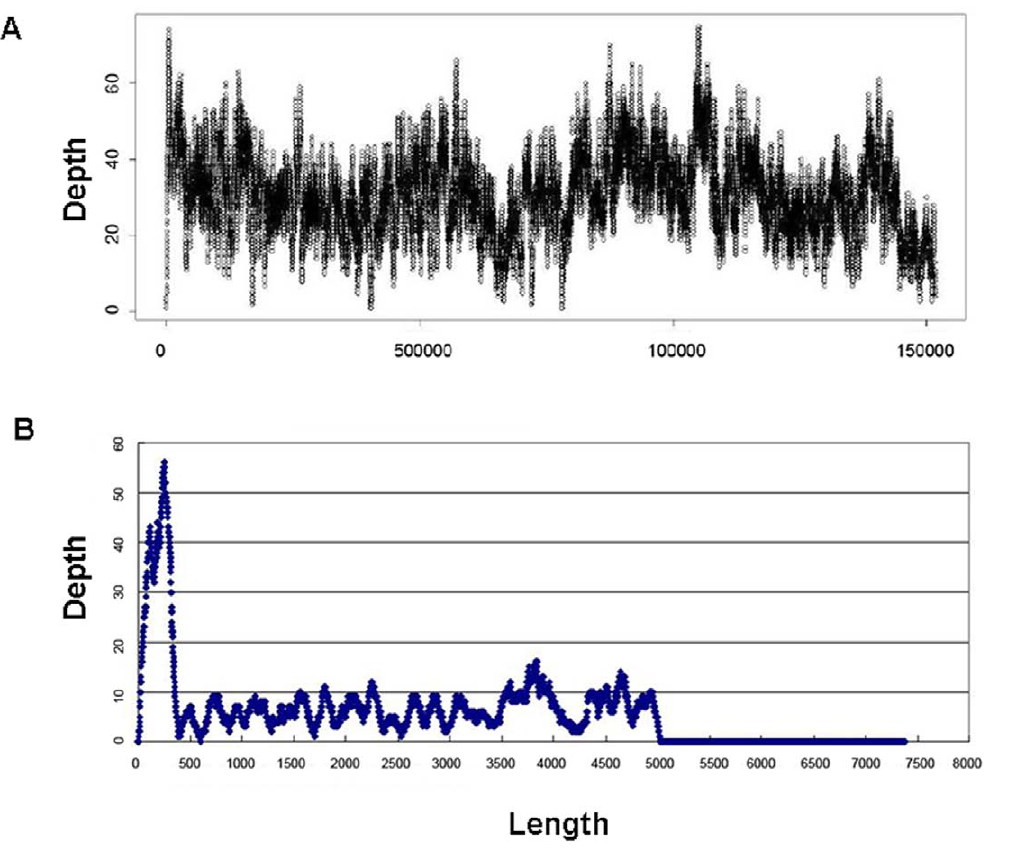
Figure 5. Sequencing depth of the hLF BAC and the pBeloBAC vector. By mapping the Illumina reads onto the (A) hLF BAC and (B) pBeloBAC vector, the sequencing depth was calculated in 10-bp sliding windows of 5 bp. The X-axis denotes the length of the (A) hLF BAC and (B) pBeloBAC vector in bp, and the Y-axis denotes the sequencing depth.